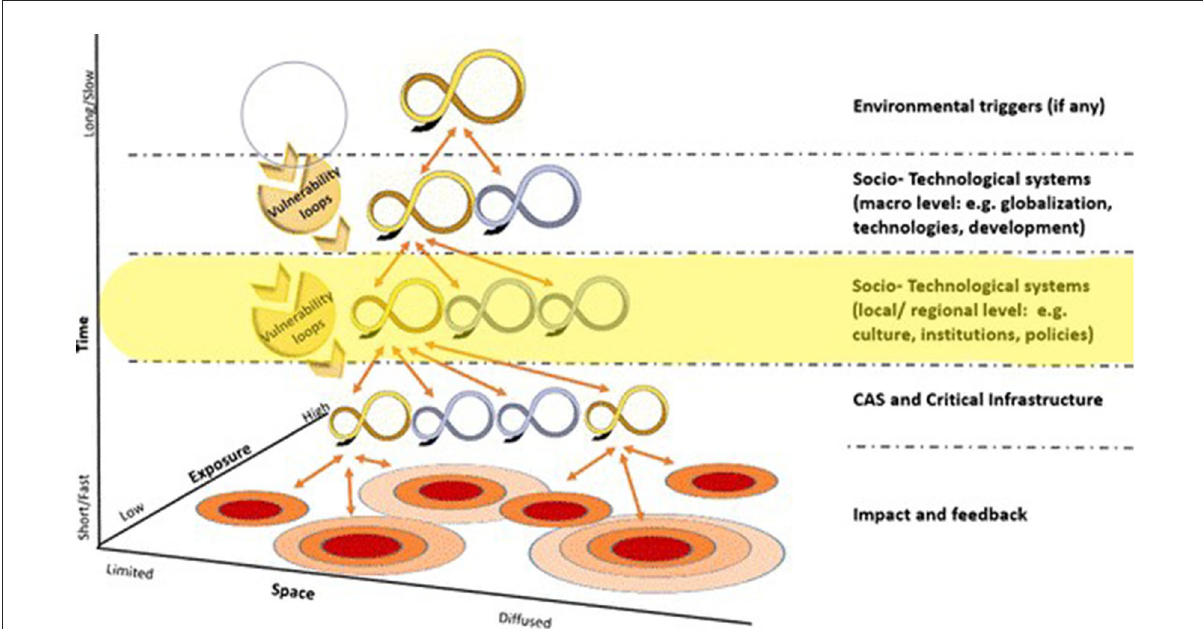
FIGURE2 Different scales, feedbacks, and vulnerability paths in cascading disasters. From Pescaroli and Alexander